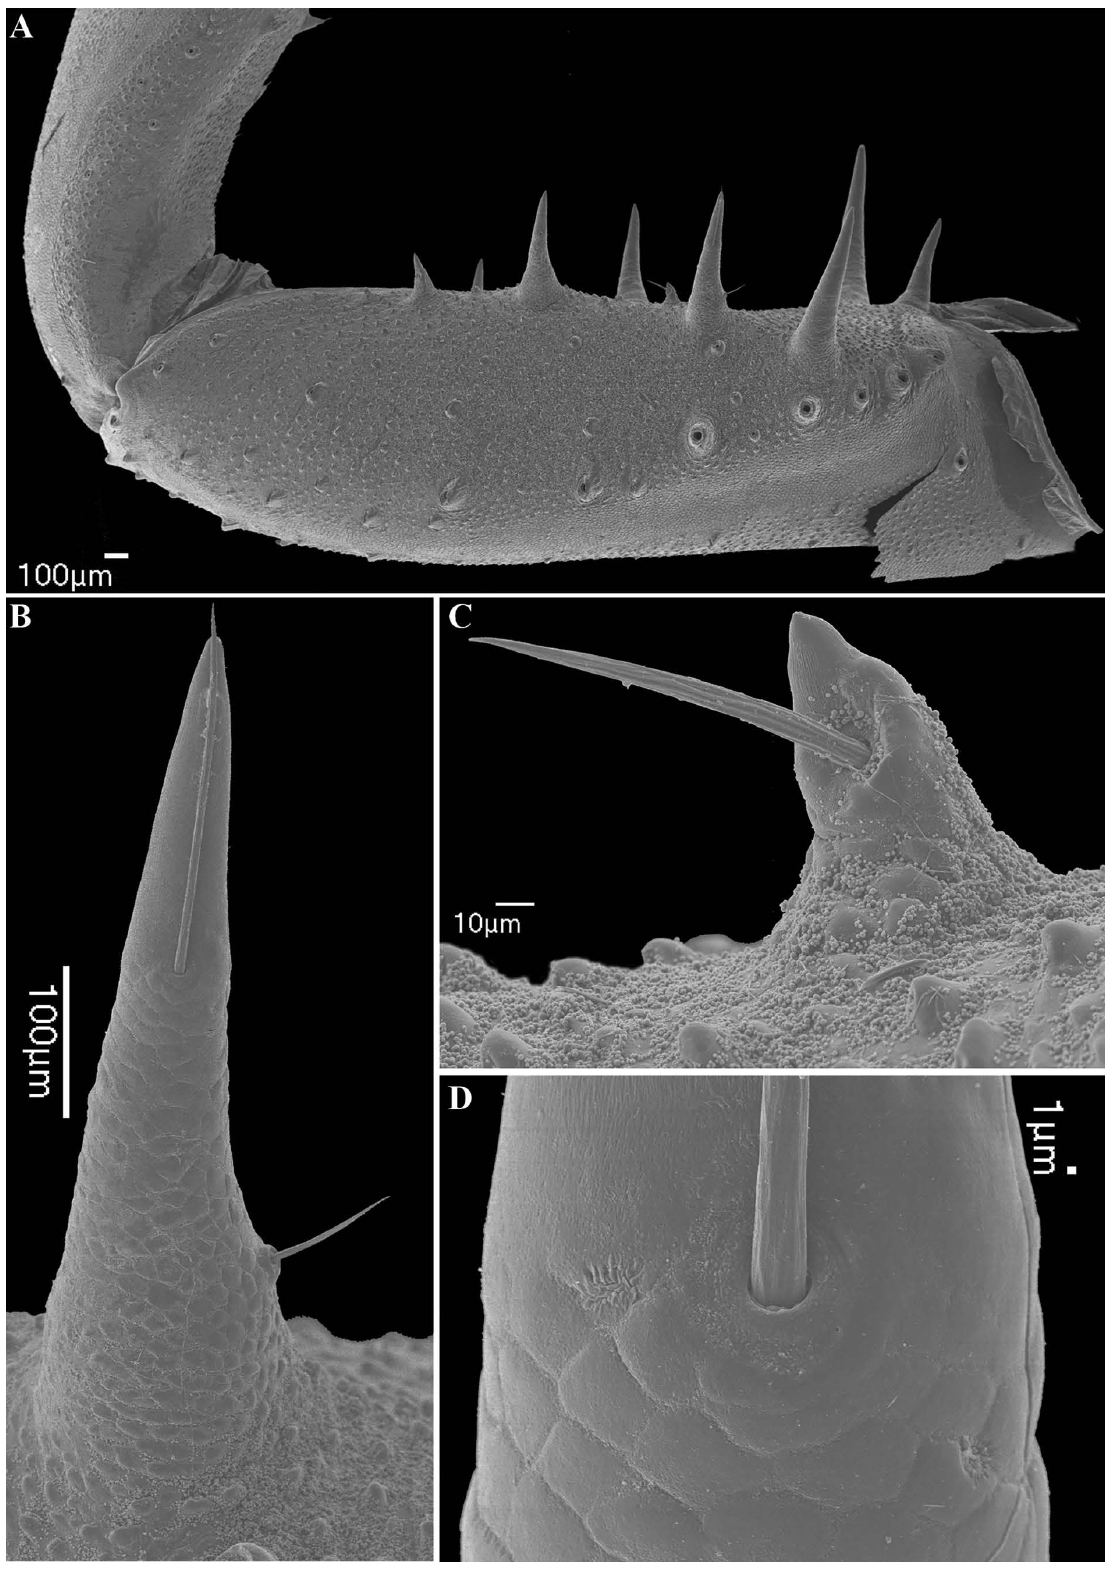
Fig. 40. Charinus insularis Banks, 1902 (RBINS), pedipalp. A . Dorsal view. B . Spine of primary series. C . Small spine. D . Base of seta and glandular/sensory opening of spine in primary series.